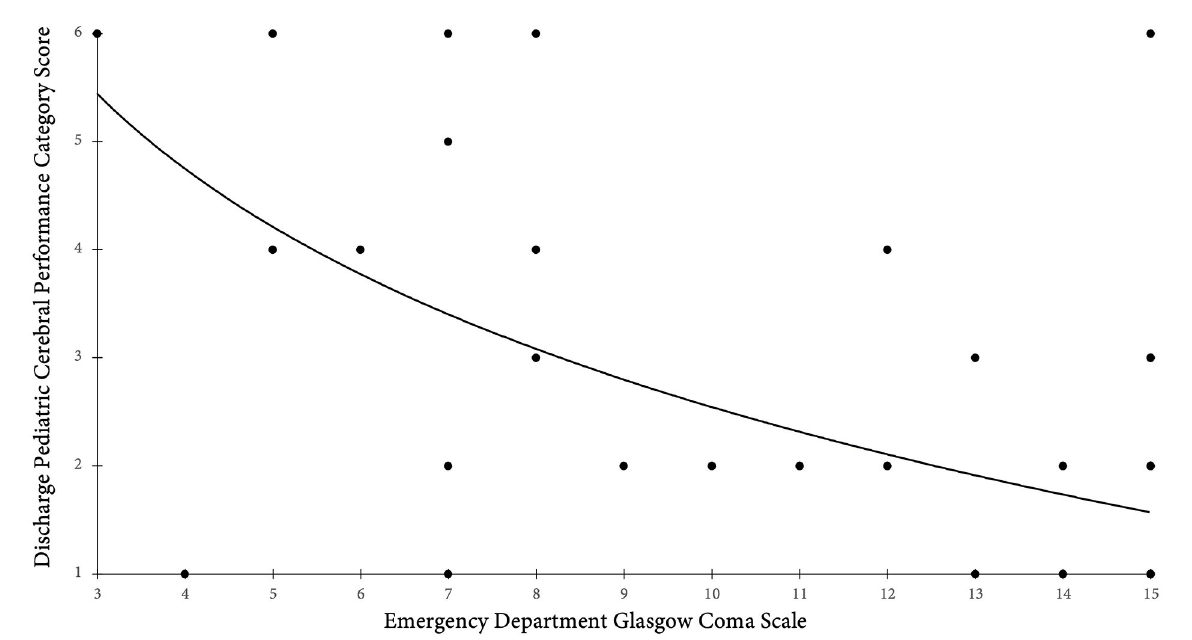
FIGURE4 Presenting Glasgow Coma Scale score compared to discharge PCPC score. This figure is a scatter plot with the x-axis containing the presenting Glasgow Coma Scale score and the y-axis representing the PCPC score on discharge. Higher GCS score on arrival to the hospital was associated with a favorable PCPC score, defined as a score of 1–2, on discharge ( p < 0.001). A line of best fit was abstracted. GCS, Glasgow Coma Scale; PCPC, Pediatric Cerebral Performance Score.